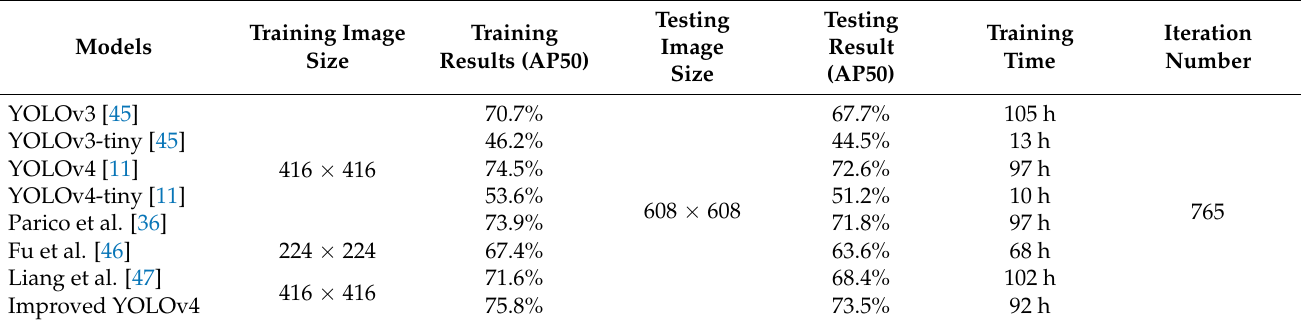
Table 6. Comparison of fruit and vegetable classification models training and testing performance with the augmented dataset.